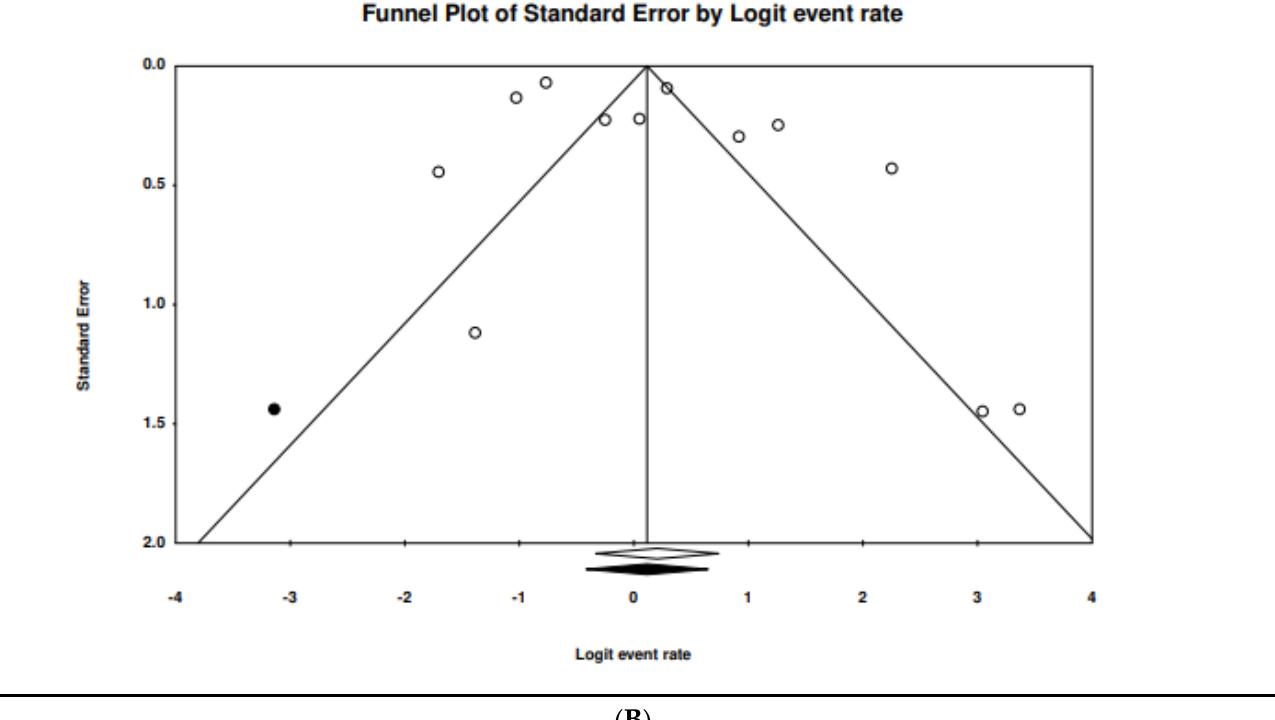
Figure 14. Funnel plot showing ( A ) publication bias in studies reporting the prevalence of bla TEM gene in antimicrobial resistant S. Typhi and ( B ) result after performing trim-and-fill method where one missing study (closed circles) was added on the left side of the mean effect.